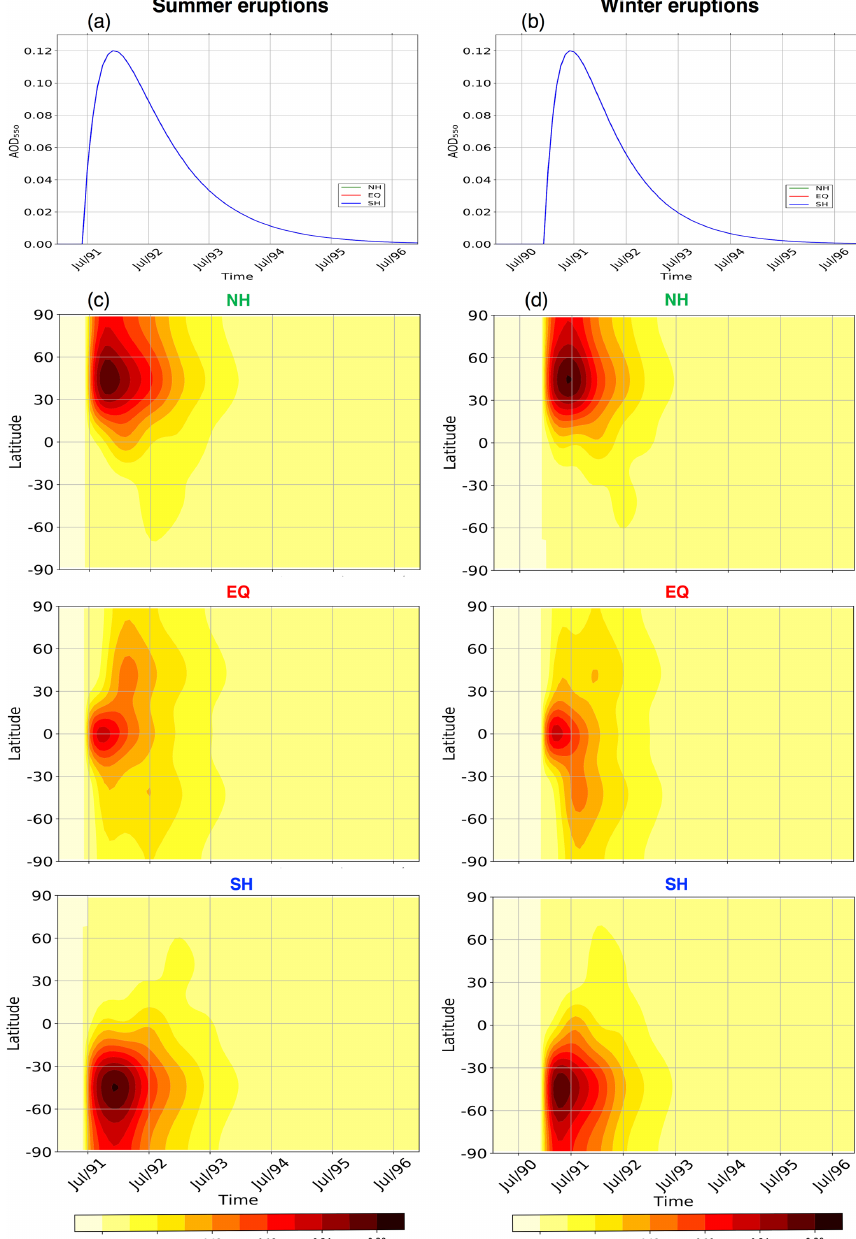
Figure 1. Global mean aerosol optical depth anomaly at 550nm for the summer (a) and winter (b) volcanic eruption cases and their zonal mean distributions (c, d)